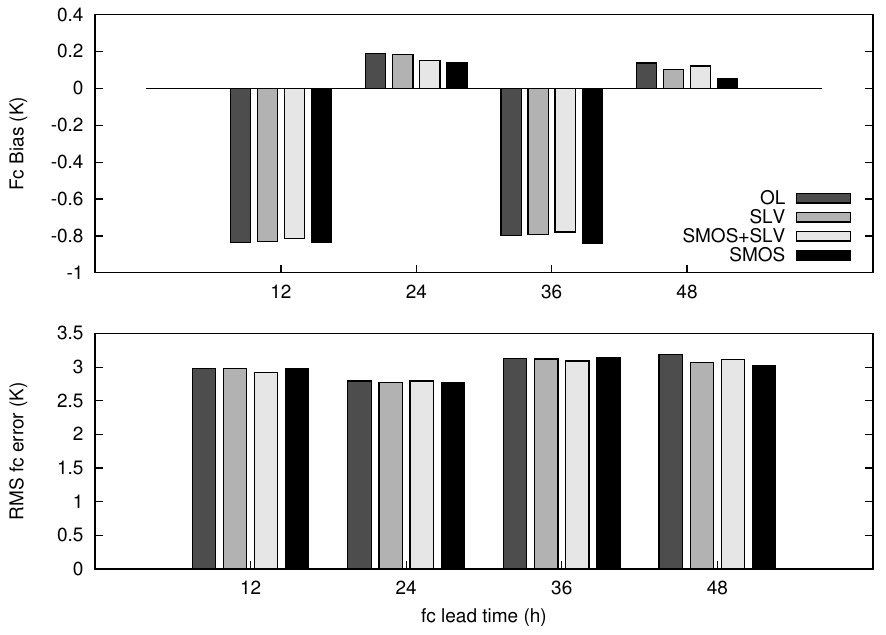
Figure 8. The same as Figure 7 but for 2 m